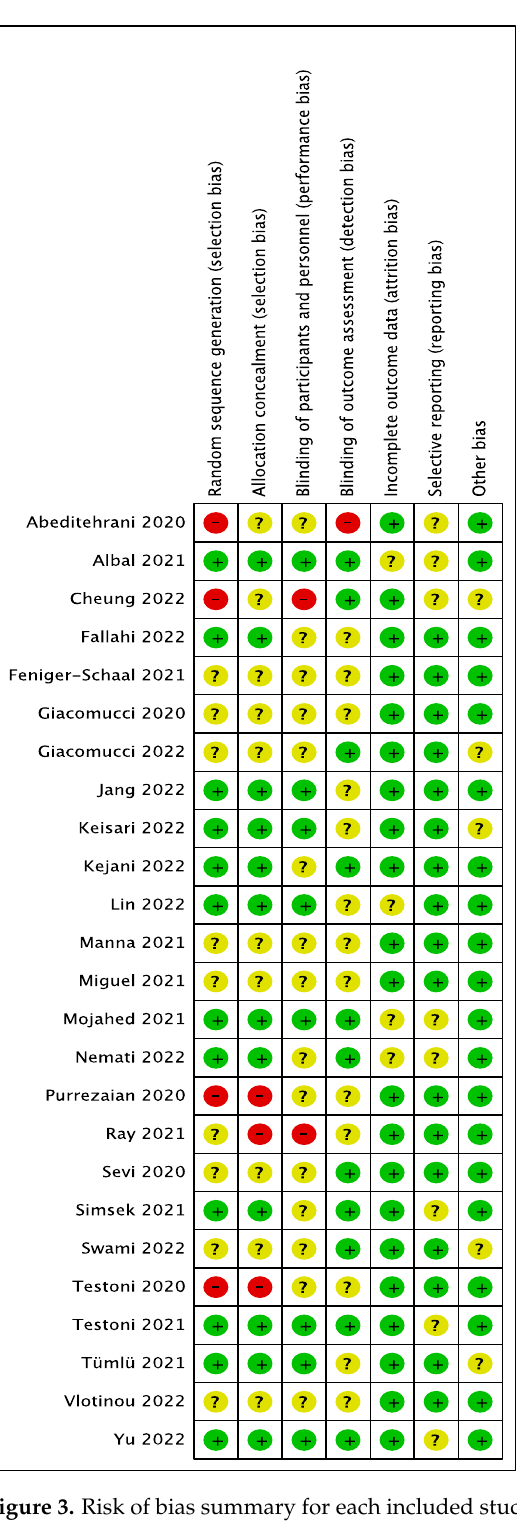
Table 3. Effects and heterogeneity for comparisons between studies.